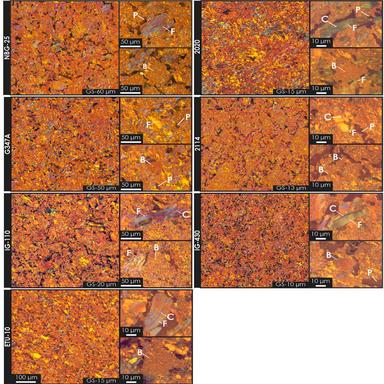
Polarized optical micrographs of fine to super-fine nuclear graphite grades. B – Binder, C – Crack, F – Filler, P – Pore. The label GS denotes the grain size of the material; the scale bar in NBG-25 applies to all low magnification micrographs presented.